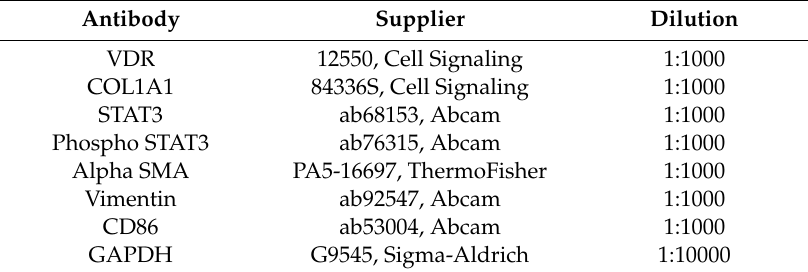
Table 4. Specific antibodies used for Western blot